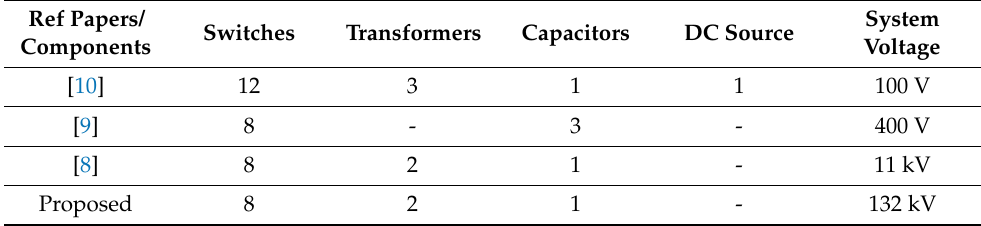
Table 3. Comparative study for existing